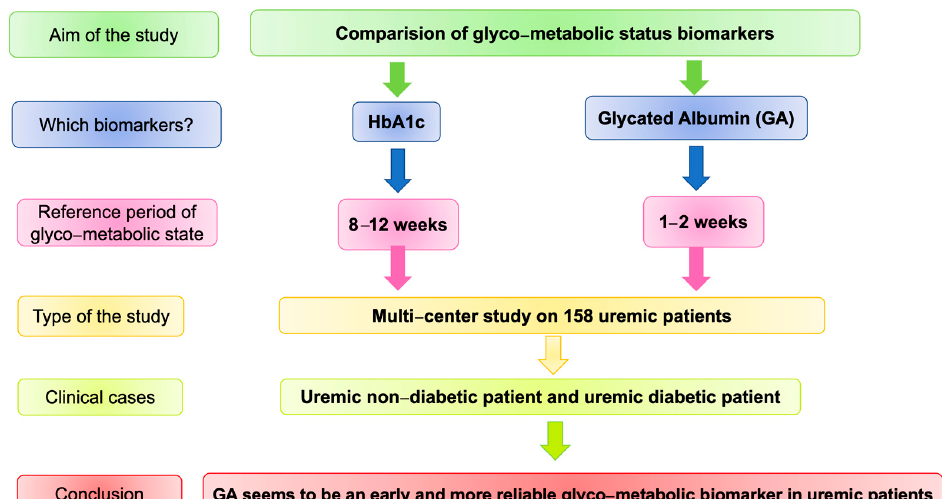
Figure 1. Design of the study. Abbreviation: HbA1c, glycated hemoglobin.